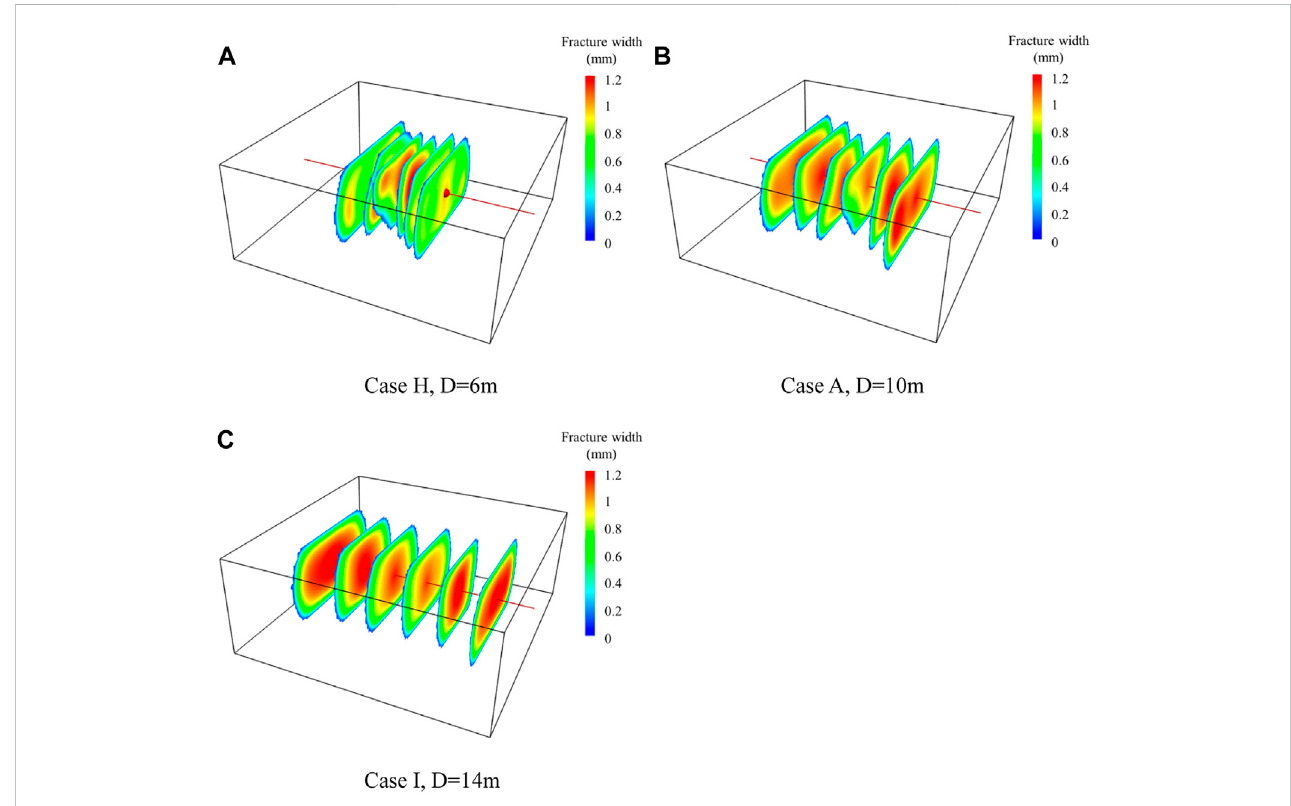
FIGURE 9 Fracture morphology for three cases with different cluster spacing. (A) Case H, D = 6 m. (B) Case A, D = 10 m. (C) Case I, D = 14 m.